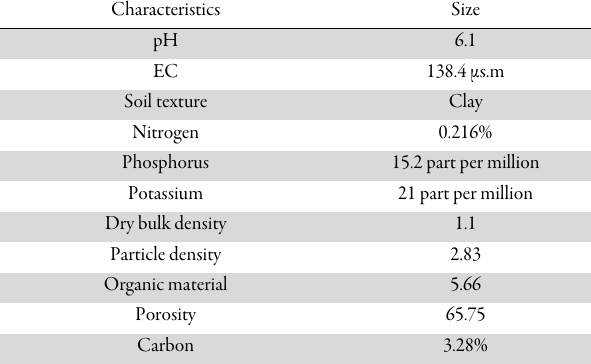
Table 1. Soil properties of the present study Characteristics